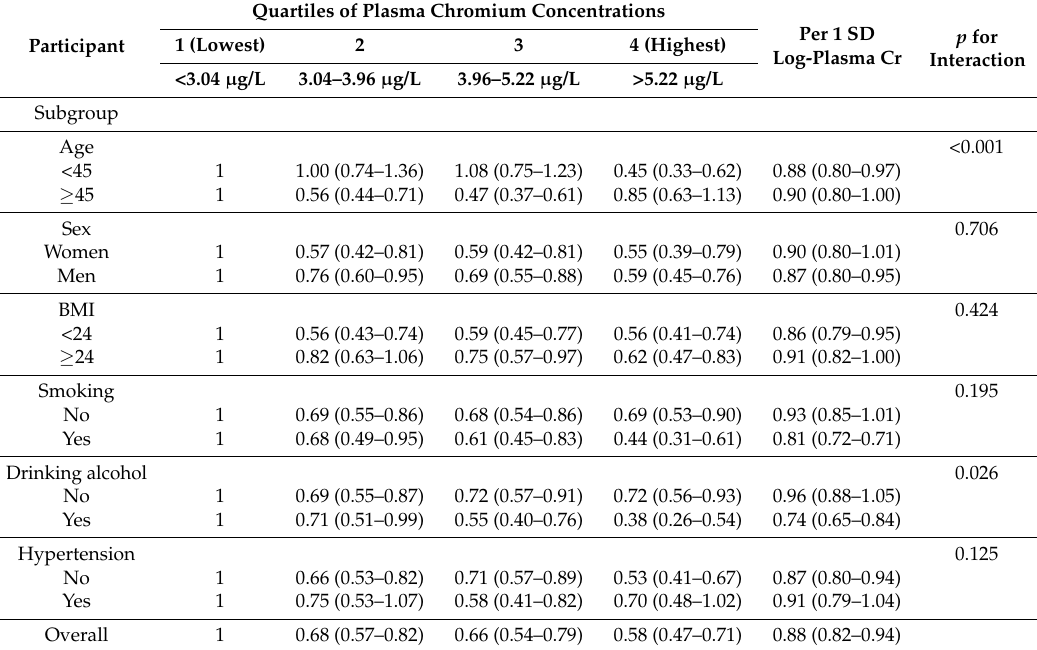
Table 3. Adjusted ORs for T2DM and pre-DM of plasma chromium in subgroups. Quartiles of Plasma Chromium Participant